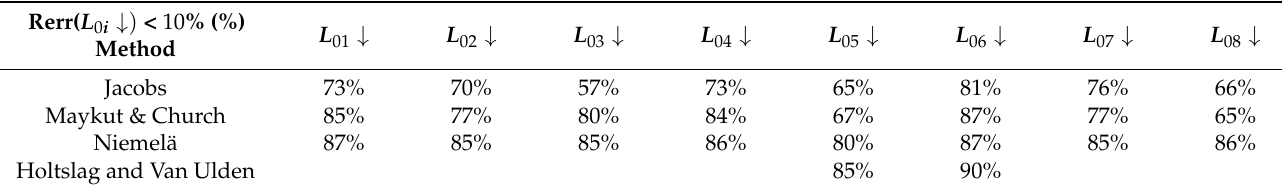
Table 14. Number of situations in percentages (%), with relative errors (R err ) smaller than 10%. Columns represent: (cid:0) (cid:1) L 0 i , i = 1,...,8 ↓ , respectively, as in Table 11. Rows represent cloudiness corrections: Jacobs [49], Maykut and Church [50], Niemelä et al. [43] and Holtslag and Van Ulden [5]-type corrections L CL 6 ↓ . For cloudiness corrections, these abbreviations are used for the ( L 0 i ) index: Jacobs (Jac), Maykut and Church (M&C), Niemelä (Nie) and Holtslag and Van Ulden (HVU), respectively.